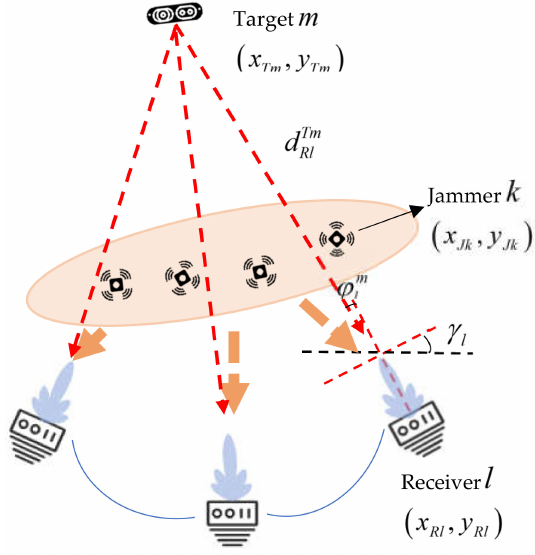
Figure 1. Model of the target, jammer, and sensor